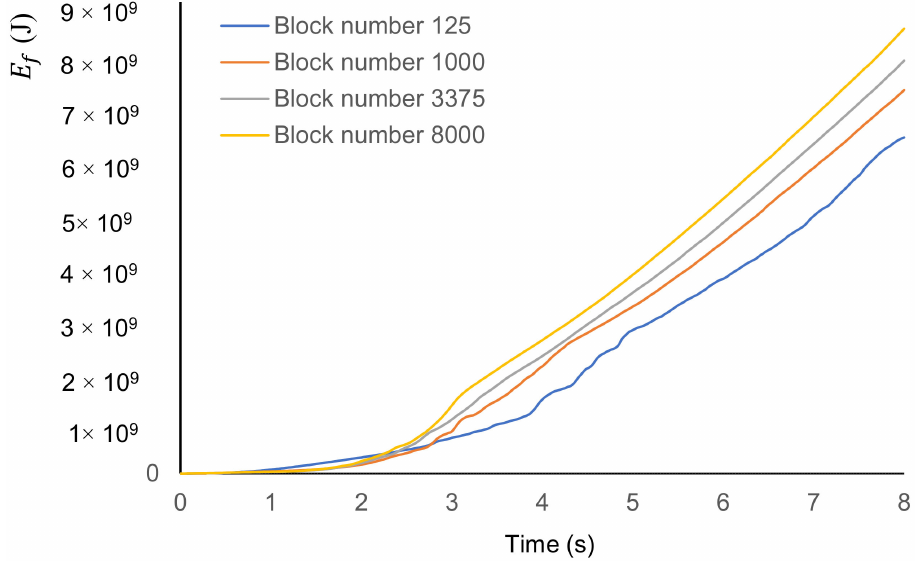
Figure 13. Energy generated by friction from 0 s to 8 s under conditions of 125, 1000, 3375, and 8000